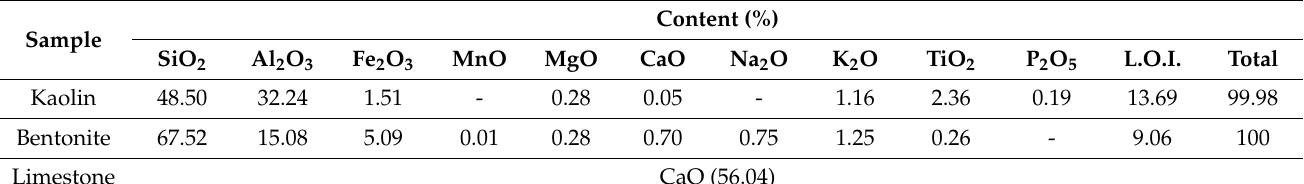
Table 2. Various oxides contained in the raw